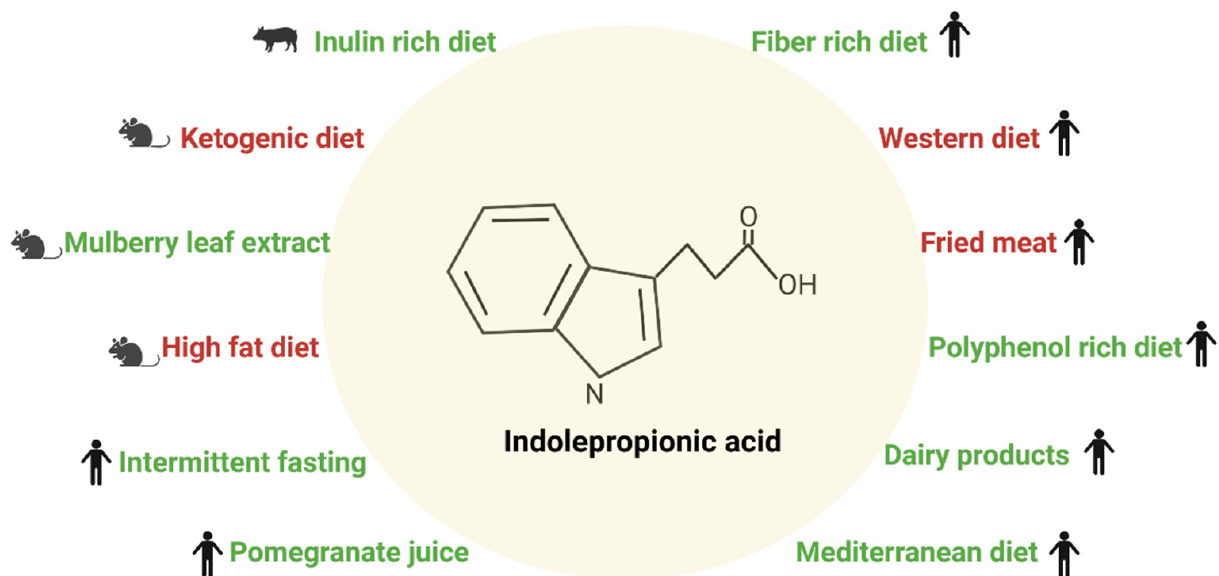
Figure 2. Effect of a specific type of diet on circulating indolepropionic acid levels. The green color text means the IPA levels were found to be increased and had a beneficial effect and the red colored text means the levels were reduced and were harmful. The symbols in the figure represent the model system (mouse, pig, or human) used for studying the effects of IPA.